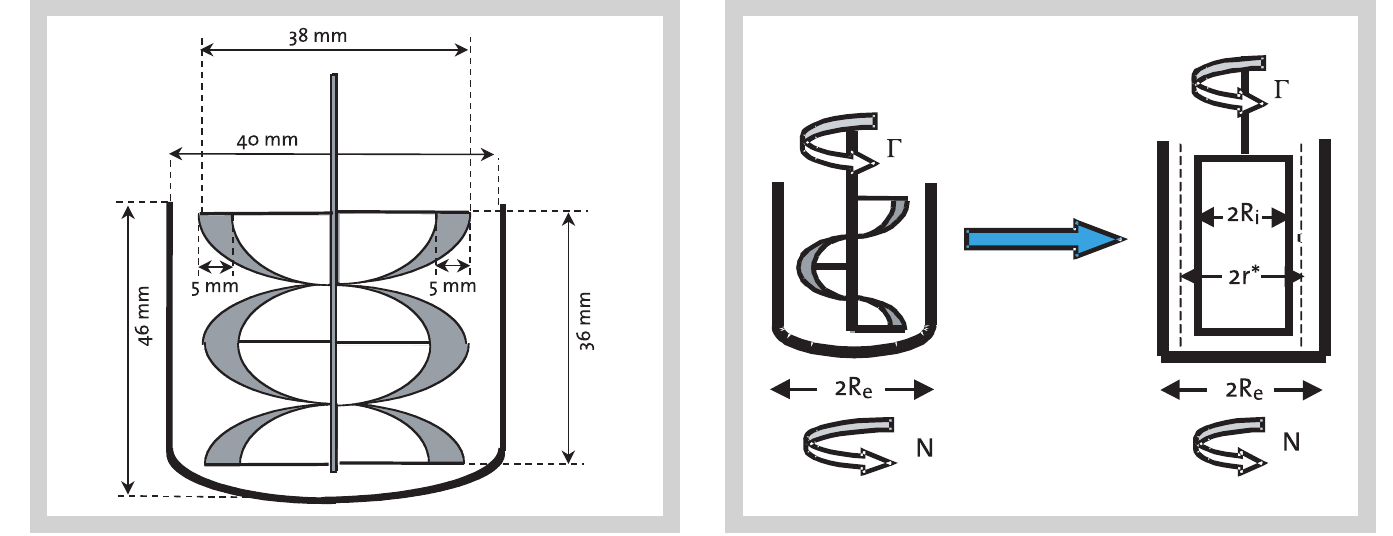
Figure 1 (left): Schematic of the rheo-reac- tor. Figure 2: Couette analogy for a com- plex